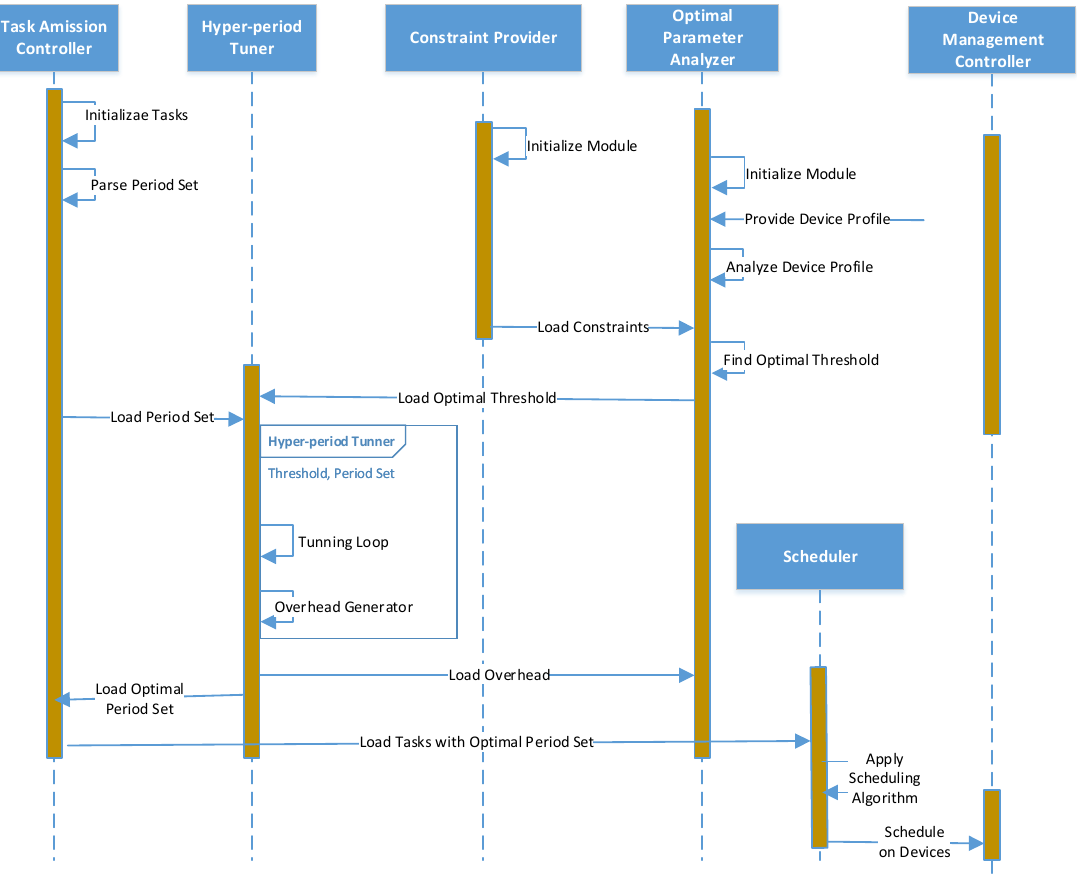
Figure 4. Interaction model among different